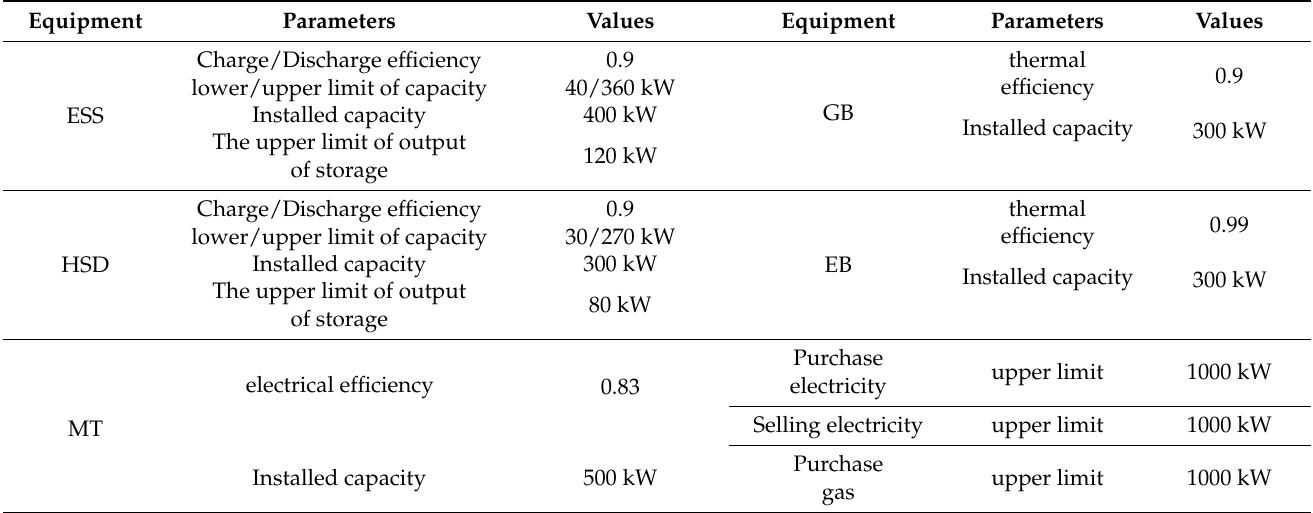
Table 1. Equipment Parameters.